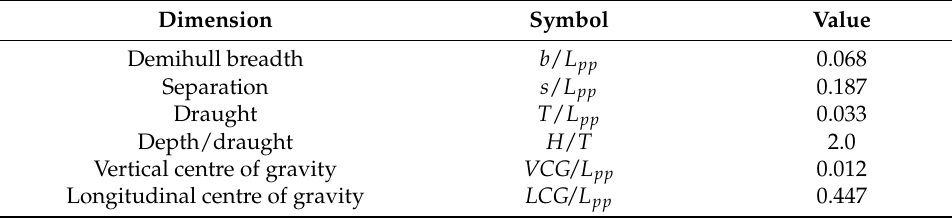
Figure 1. The geometry of the London demonstrator. Table 1. Main dimensions of the TrAM London Demonstrator catamaran.